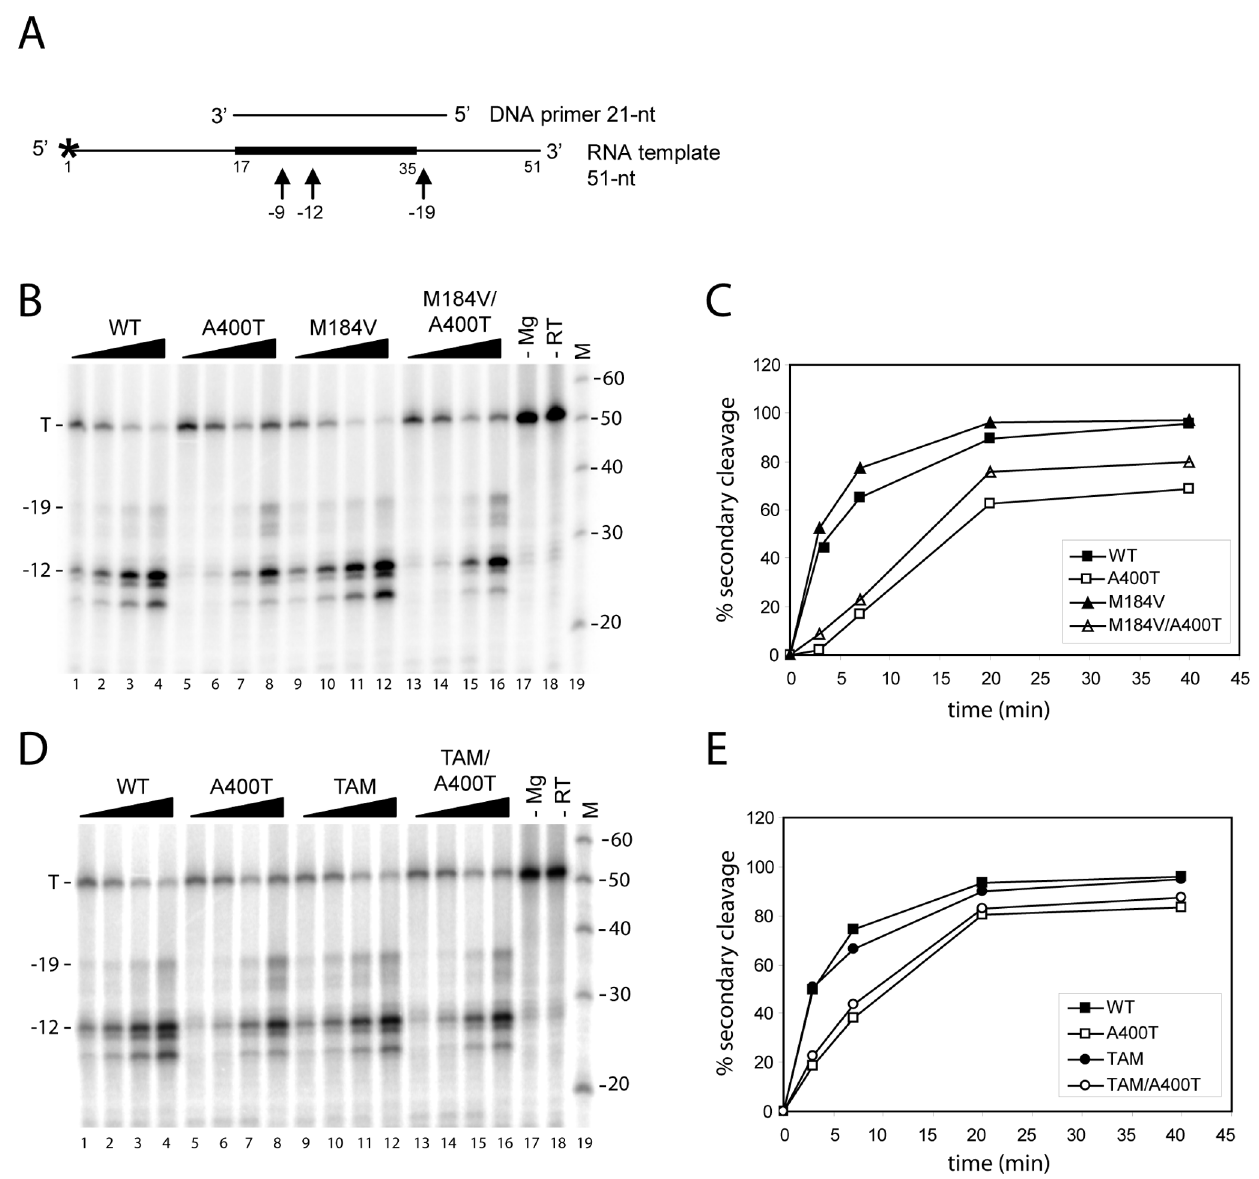
Figure 3. RNaseH activity of virus-derived RT enzymes containing substitution A400T. (A) RNaseH cleavage was measured using a 5 9 -end labeled (asterisk) 51-nt HIV-1 RNA template representing the PBS region. A 21-nt DNA primer complementary to the PBS was heat-annealed onto the RNA template. Primary ( 2 19) and secondary ( 2 12/ 2 9) cleavages were monitored. (B) Representative gel showing RNaseH cleavage mediated by the virion-derived RTs with substitution A400T in the wild-type and M184V background. The reactions were initiated by the addition of Mg 2 + , and template (T) cleavage was monitored after 3, 7, 20 and 40 min of incubation. Control reactions were performed in the absence of Mg 2 + (lane 18) or RT (lane 19), showing no template degradation. (C) The formation of secondary cleavage products over time was quantified, and is plotted for this representative gel. (D) RNaseH cleavage mediated by the virion-derived RTs with substitution A400T in the wild-type and TAM background was analyzed, and formation of secondary cleavage products is plotted in (E). Representative experiments are shown, and three independent experiments were performed with similar results.